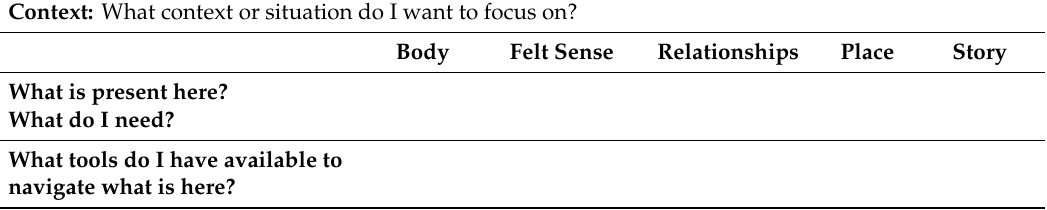
Table 3. Recognition of needs and tools across nodes in a